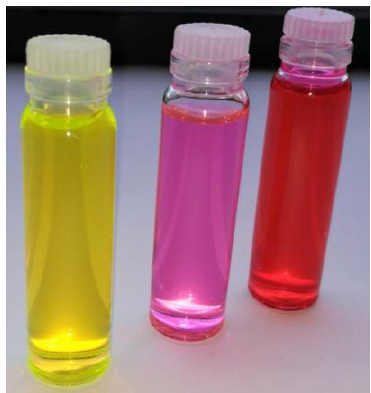
Figure 3. Photograph showing the di ff erent in colour of CH 2 Cl 2 solutions of (left to right) 1 , 2 , and 3 . The redox behaviour of 1 , 2 and 3 in CH 2 Cl 2 solution was investigated by cyclic voltammetry and UV-Vis spectroelectrochemistry (Table 1). In line with previous observations all oxidations and reductions are based on the dipyrrin component of the molecule [45]. An electrochemically reversible one electron reduction process is observed for each compound (Figure 4) with the presence of the iodo substituents shifting this redox process to more positive values by more than 0.2 V, i.e., making the compound easier to reduce. The introduction of the morpholino substituents in 3 shifts the potential to a more positive potential in comparison to 2 suggesting a further decrease of electron density in the BODIPY manifold. In all cases oxidation processes were observed at positive potentials (Figure 4 and Table 1). For 1 and 2, the oxidation appears reversible at faster scan rates, but as the scan